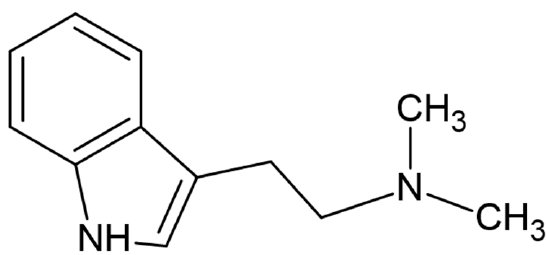
(DMT) (Figure 1) from P. viridis , which behaves as an agonist of serotonin receptors (5- HT1A/2A/2C) [3]. When ingested alone, this compound is inactive, as it is rapidly metabolized by peripheral monoamine oxidase A (MAO-A) [8]. However, in the presence of β -carbolinic alkaloids, such as Harmaline, Harmine and Tetrahydroharmine (THH), from B. caapi , DMT can access the central nervous system, since these are temporary inhibitors of hepatic and intestinal MAO-A [2]. THH also acts as a serotonin reuptake inhibitor, enhancing the effects of DMT [2,3]. The knowledge about this synergy between compounds present in the two plants has been known by indigenous peoples for about 3000 years [9].